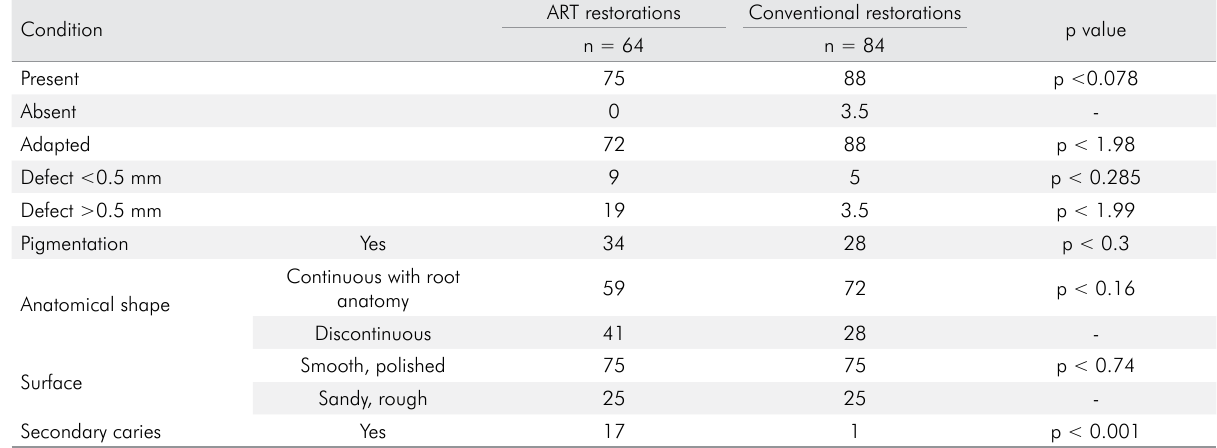
Table 2. Six-month assessment of the presence and condition of the restorations (%).